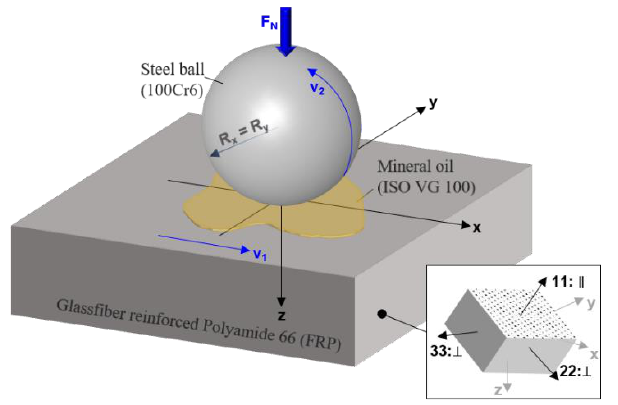
Figure 2. Schematic representation of the investigated contact configuration including the global (xyz)-coordinate system and the local (123)-coordinate system of the FRP.